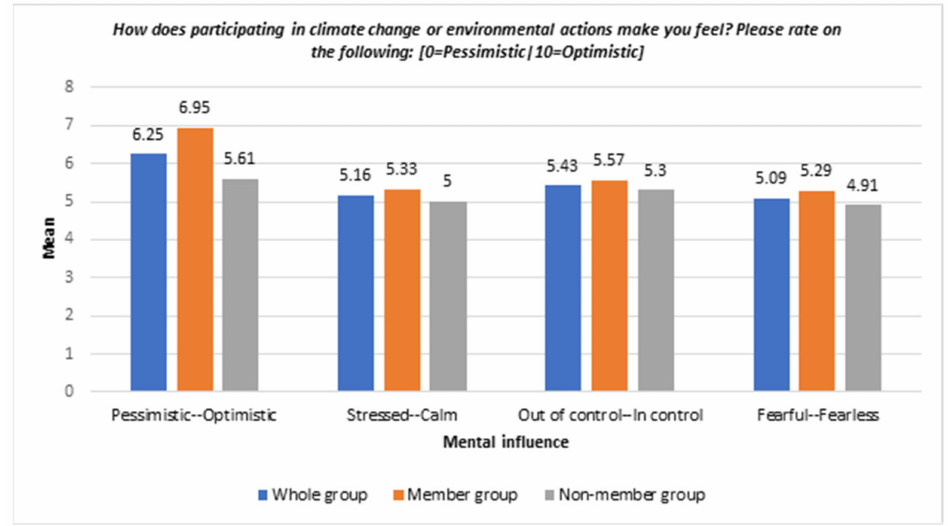
Figure 2. Bar chart of positive mental health impacts via different environmental activities—whole sample and between